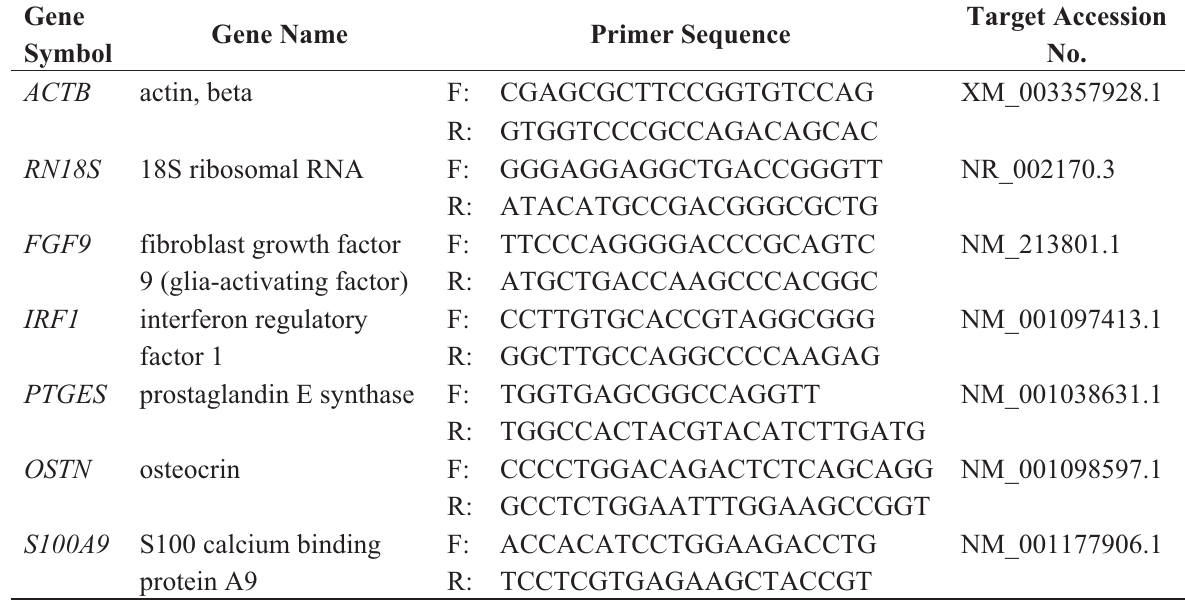
Table 1. Primer sequences for quantitative real-time